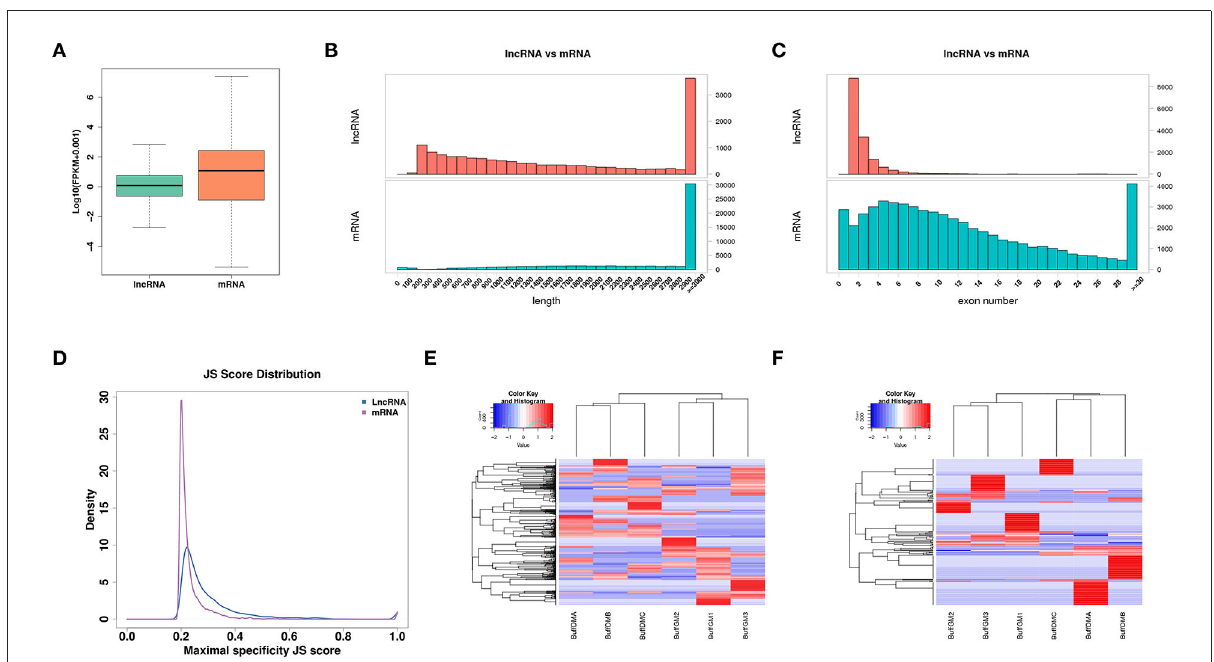
FIGURE2 Expression profiles of lncRNAs in proliferating and differentiating buffalo myoblasts. (A) The distribution of expression levels of lncRNAs and mRNAs. (B) The distribution of transcript lengths of lncRNAs and mRNAs. (C) The distribution of exon number of lncRNAs and mRNAs. (D) A Jensen-Shannon divergence score was used to analyze the tissue expression specificity of lncRNAs and mRNAs. (E,F) The lncRNA and mRNA with JS scores > 0.5 were screened and a heatmap was drawn according to their expression levels to verify their expression trends and tissue expression specificities. BuffGM represents buffalo muscle cells at the proliferative phase and BuffDM represents buffalo muscle cells at the differentiation phase.